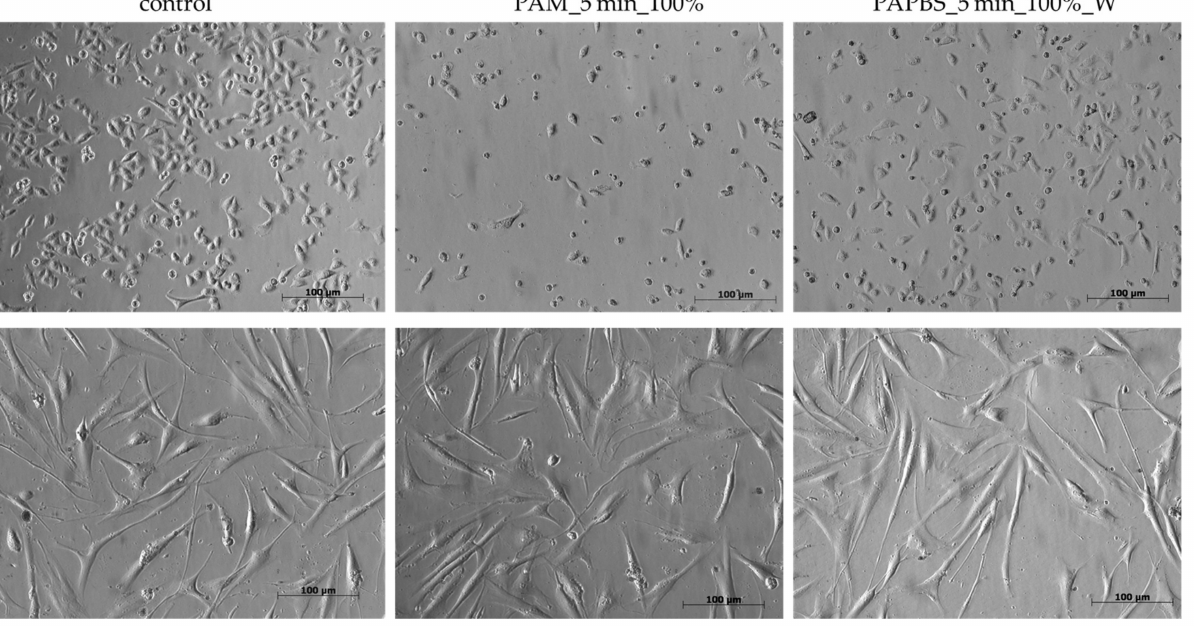
Figure 4. Effect of PAL on morphology of melanoma cells A375 and dermal fibroblasts HDFa, 24 h after PAL application. PAL were activated for 5 min. Two PAL treatments are showed: 100% plasma-activated medium (PAM) or 100% plasma- activated PBS (PAPBS) incubated with cells for 30 min and then replaced with the untreated medium (“washing”, W). (Zeiss Axio Verte.A1 optical microscope, Zeiss, Jena,